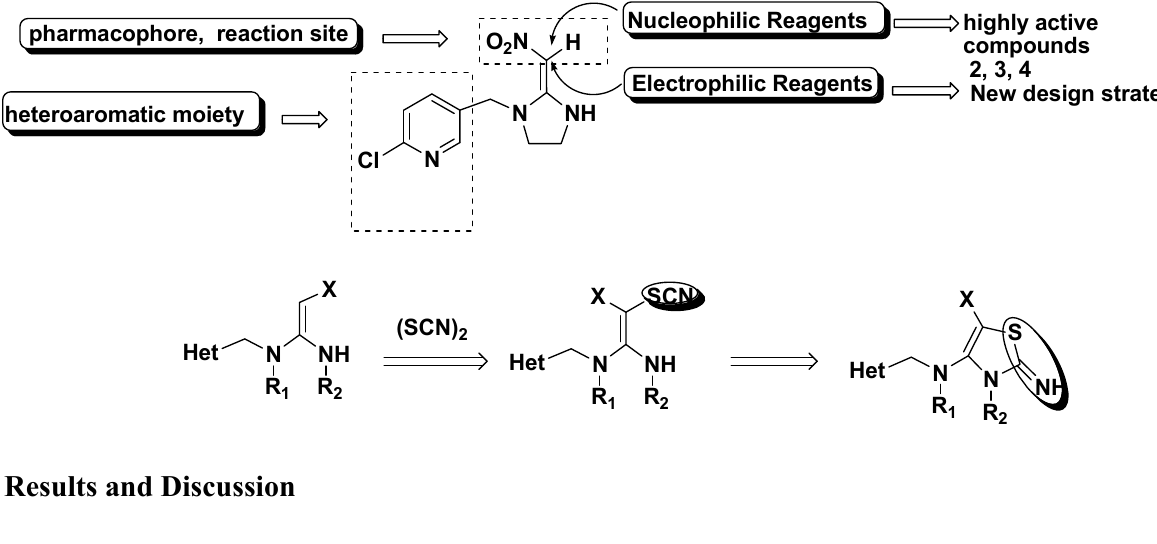
Figure 2. Structures of imidacloprid neonicotinoids and its structurally related